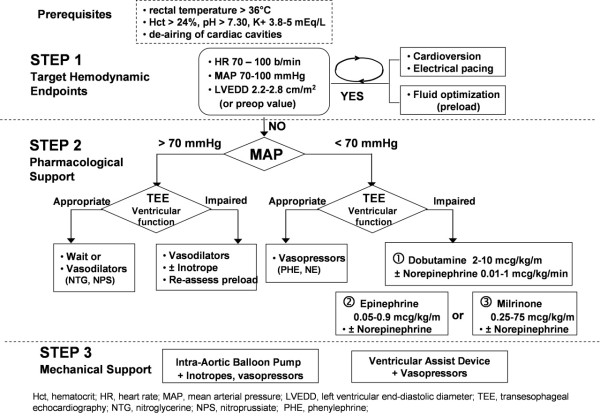
Weaning protocol from Cardio-Pulmonary-Bypass.